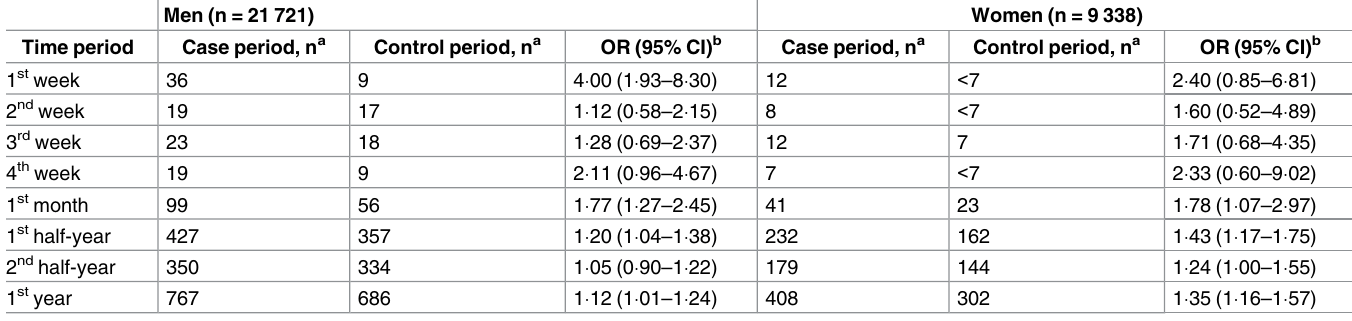
Table 2. Odds ratios (OR) and 95% Confidence Intervals (CI) of suicide after death of a close relative in 21 721 male and 9 338 female suicide vic- tims in Sweden, stratified by sex. Men (n = 21 721)